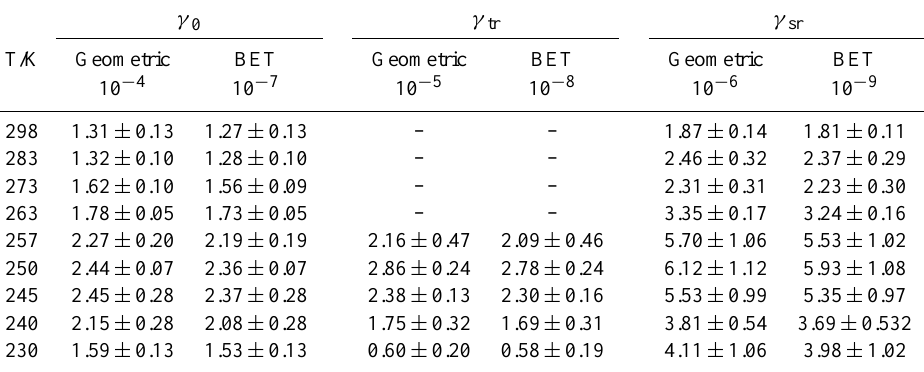
Table 2. Reactive uptake coefficient for SO 2 (4.9 × 10 14 moleculescm − 3 ) and O 3 (4.9 × 10 14 moleculescm − 3 ) on CaCO 3 at a series of tropospheric temperatures.